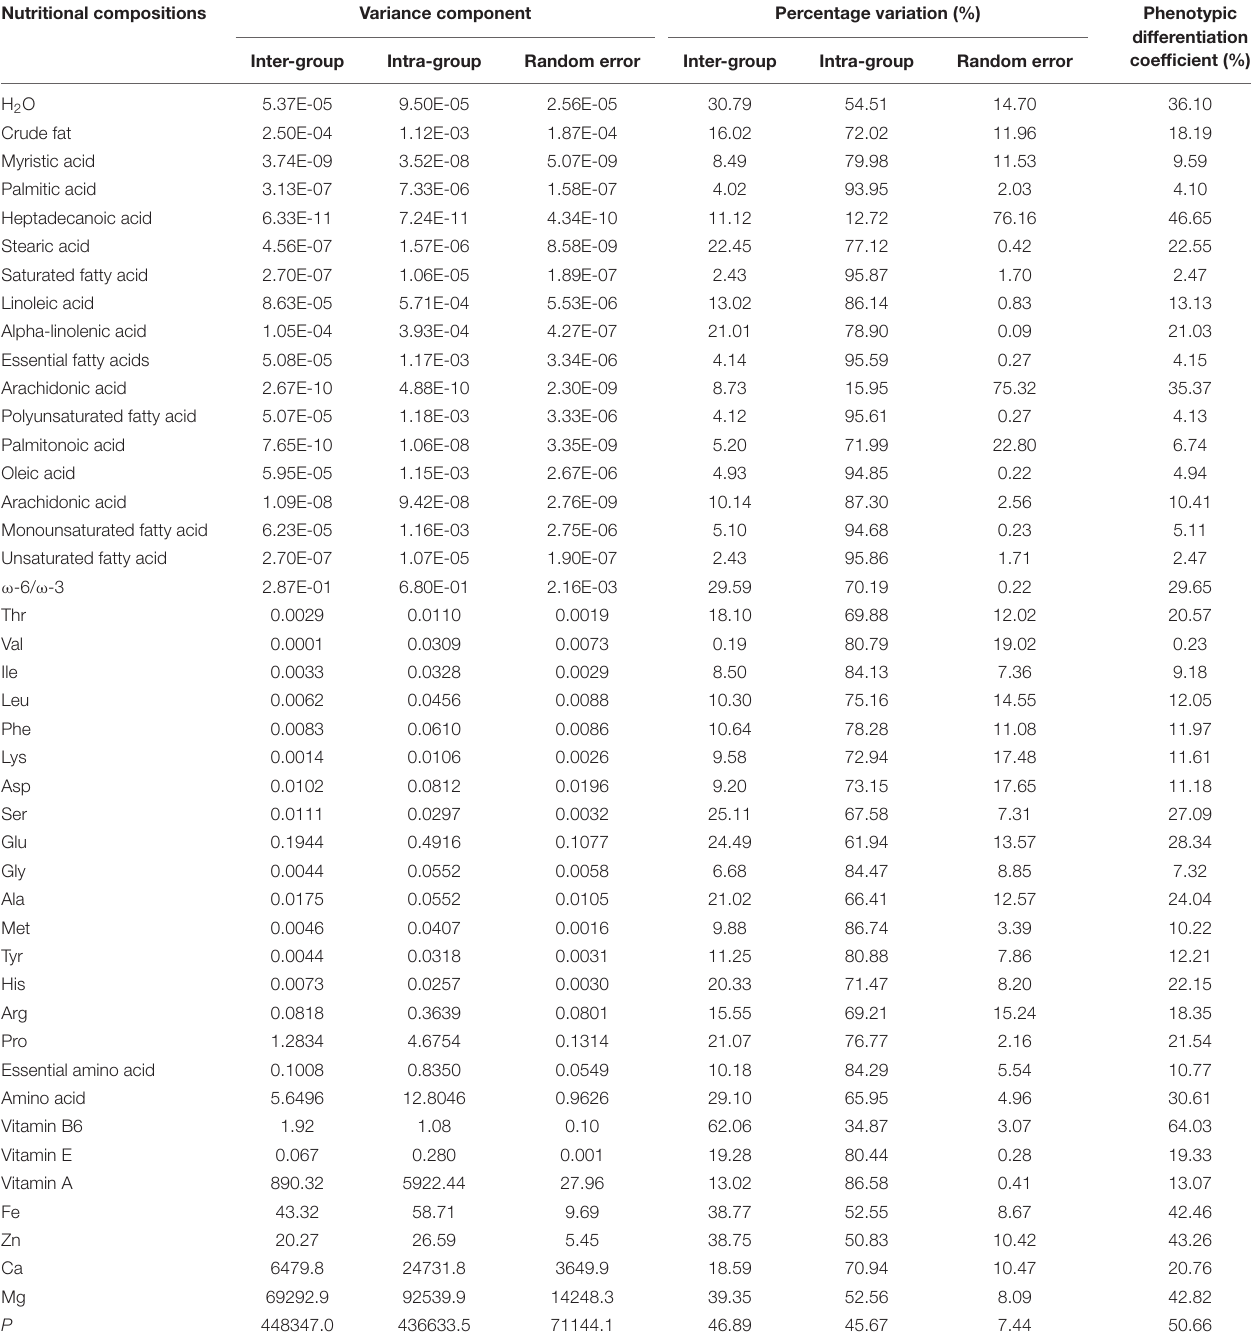
TABLE 4 | Variance component and phenotypic differentiation coefficient by kernel